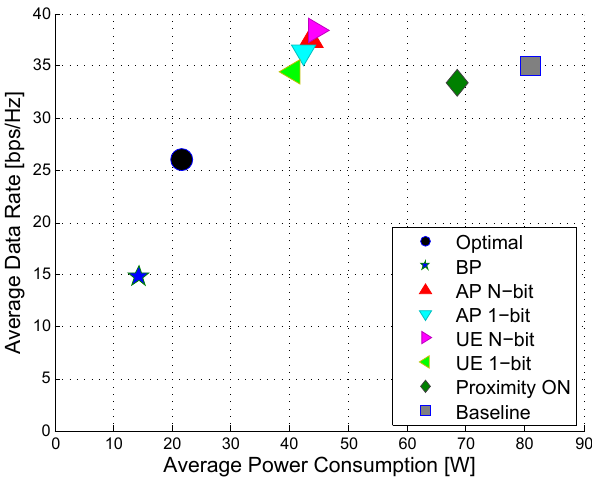
Figure 5. The average power consumption vs. the average data